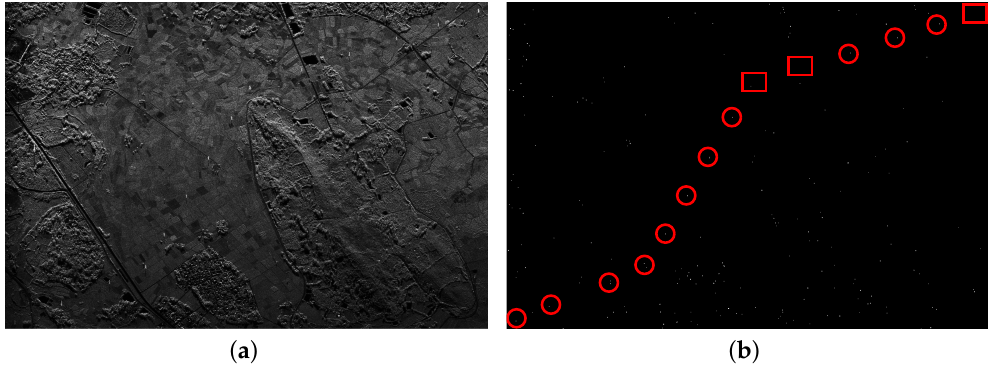
Figure 14. ( a ) filtered image based on PWF ; and ( b ) point-like target detection results.